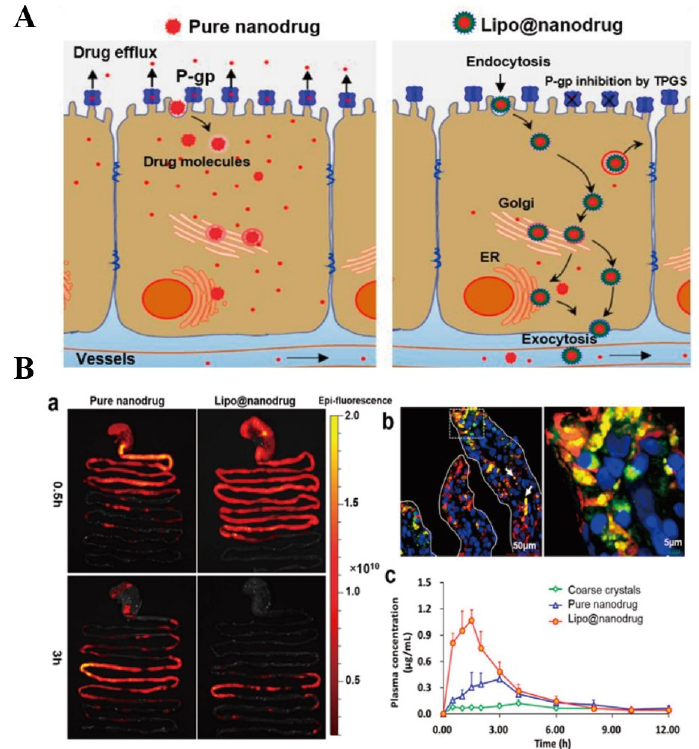
Figure 10. ( A ): Schematic illustration of potential transport mechanisms of pure nanodrug and Lipo@nanodrug. ( B ): In vivo absorption of SQV formulations. ( a ) Ex vivo imaging of NP transport through the rat GI tract at different time points; ( b ) fluorescence staining examination of intestinal mucosa absorption of Lipo@nanodrug 2 h after oral administration; and ( c ) mean SQV concentration in plasma over time after oral administration of coarse crystals, pure nanodrug, and